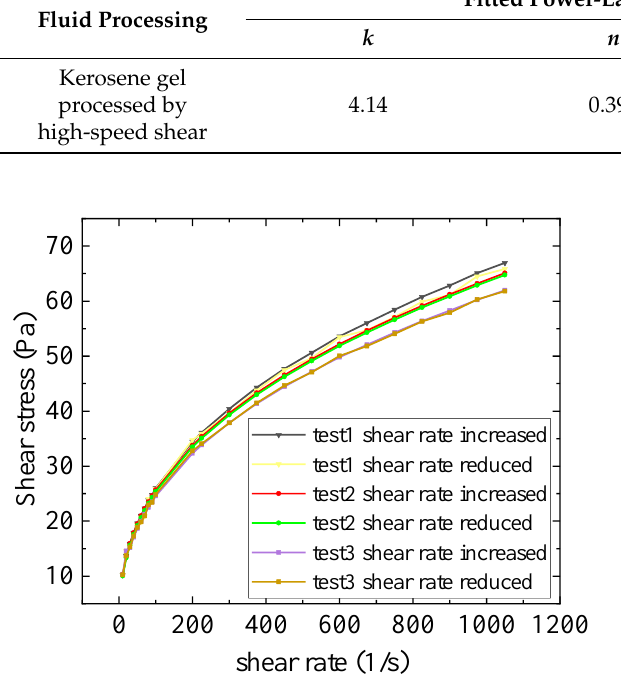
Table A3. Power-law model parameters of the gels after high-speed shearing.